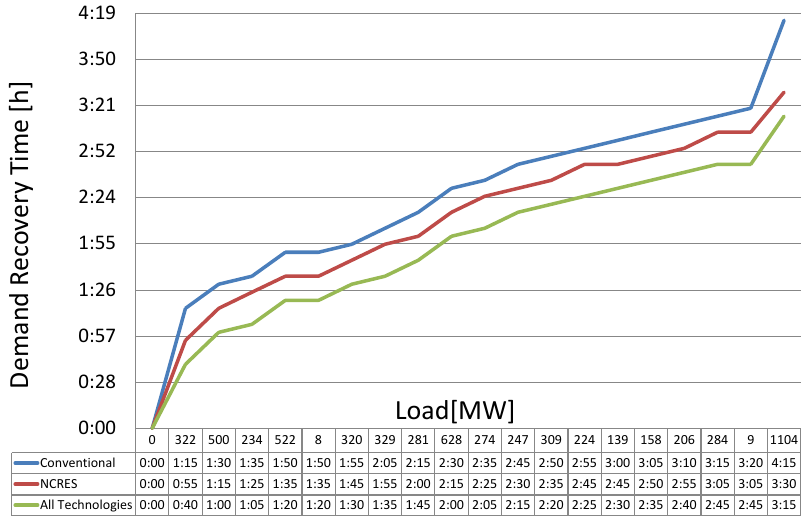
Figure 10. Demand recovery